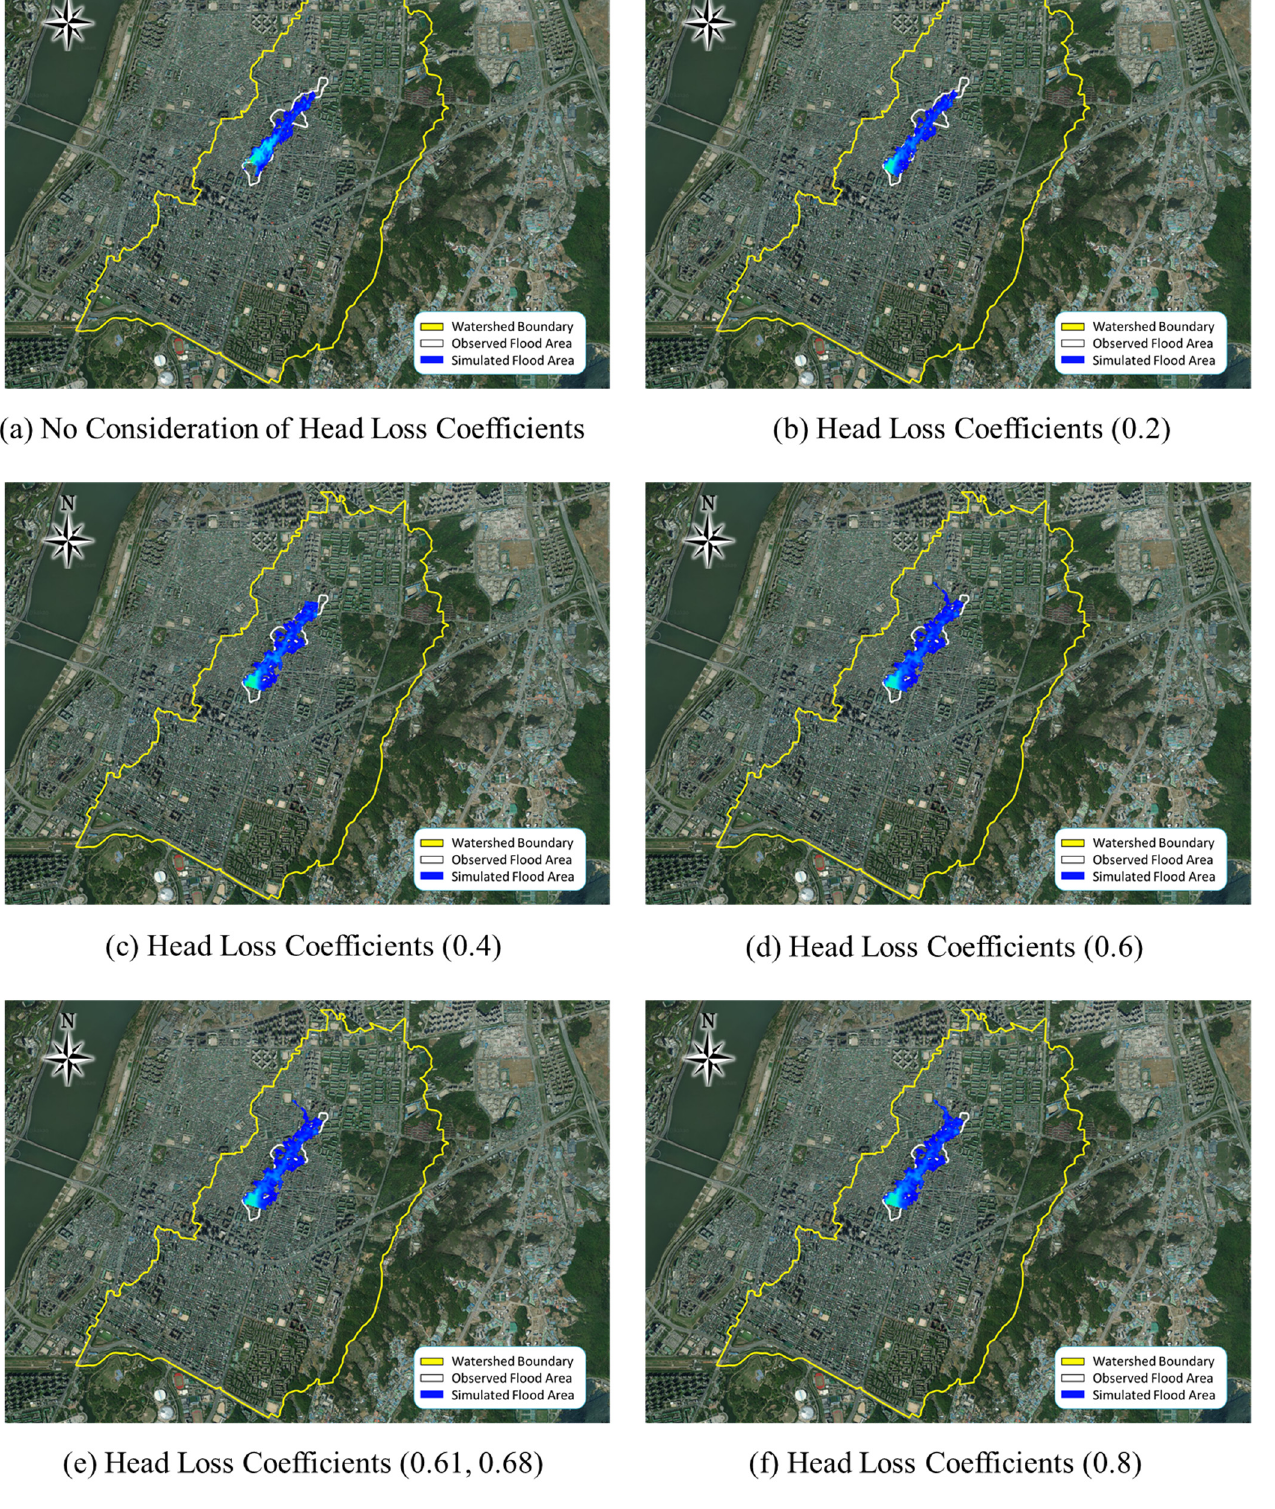
Figure 16. Comparison of the observed and simulated inundation area (Gildong watershed).